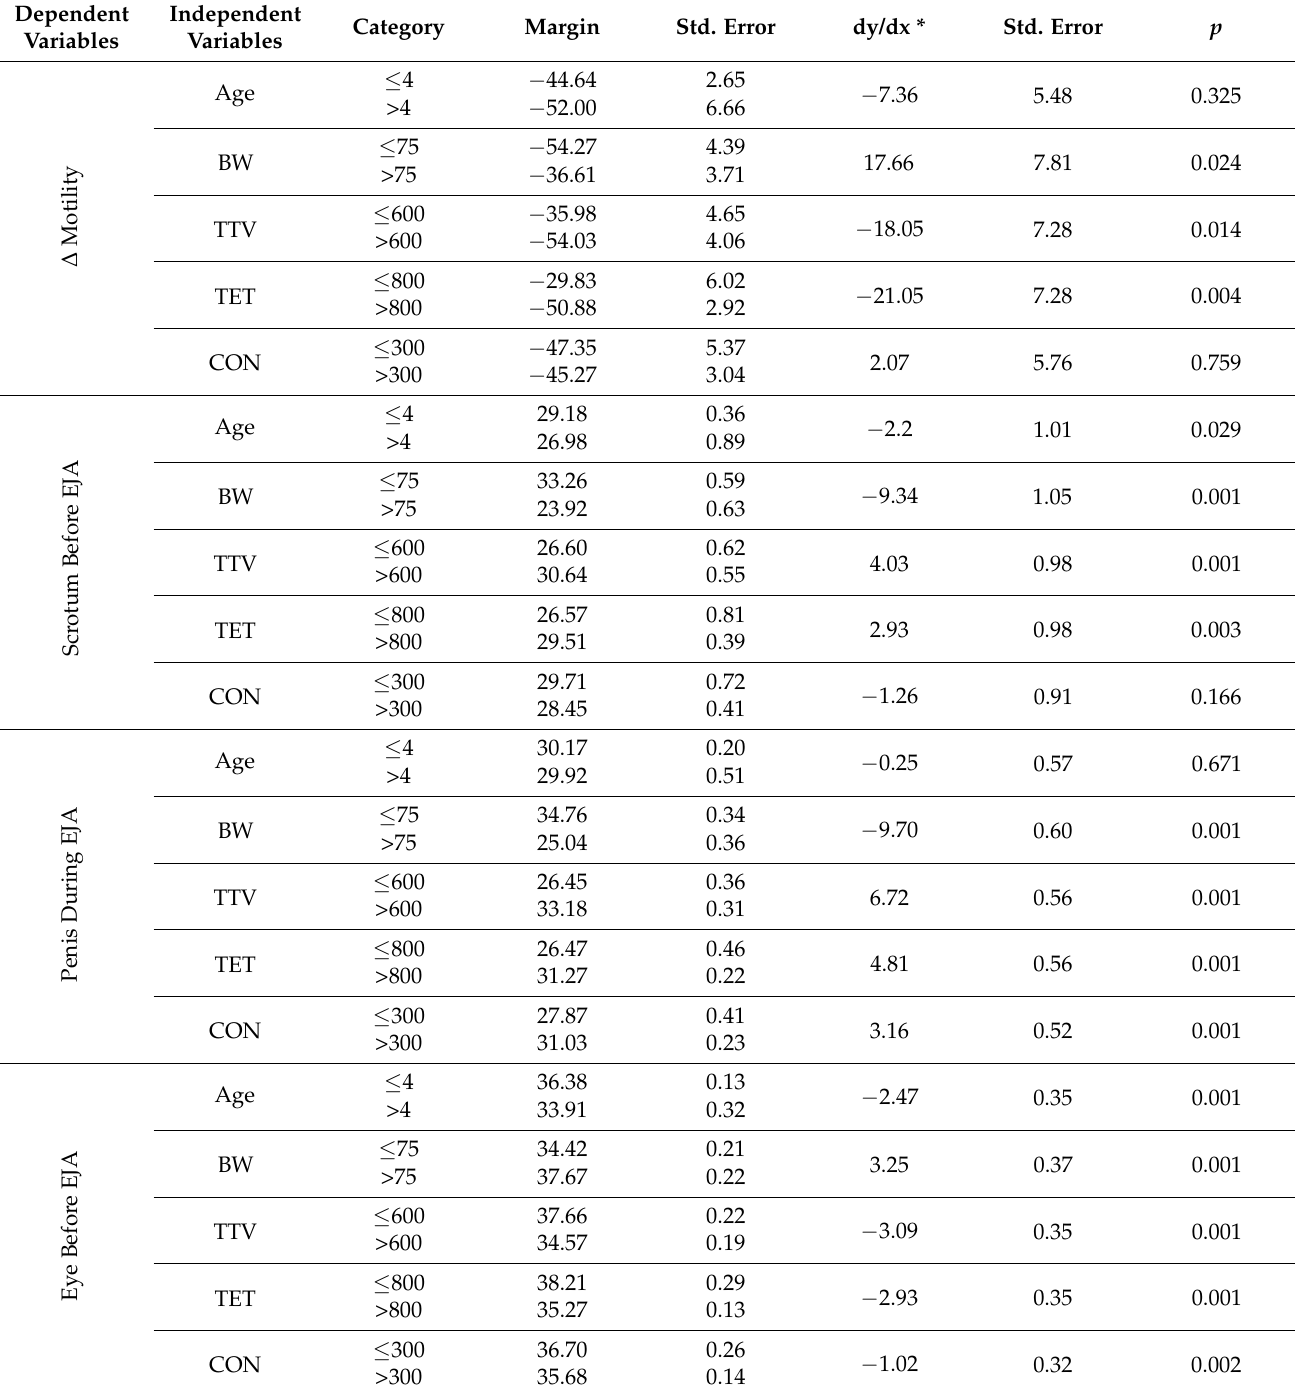
Table 4. The effect of independent values (Age, BW, TTV, TET and CON) on each selected dependent variable. Dependent Independent Category Margin Std. Variables Variables